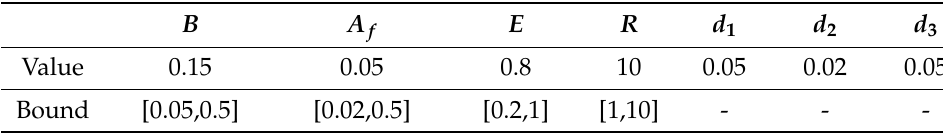
Table 1. The settings of the system uncertainties.